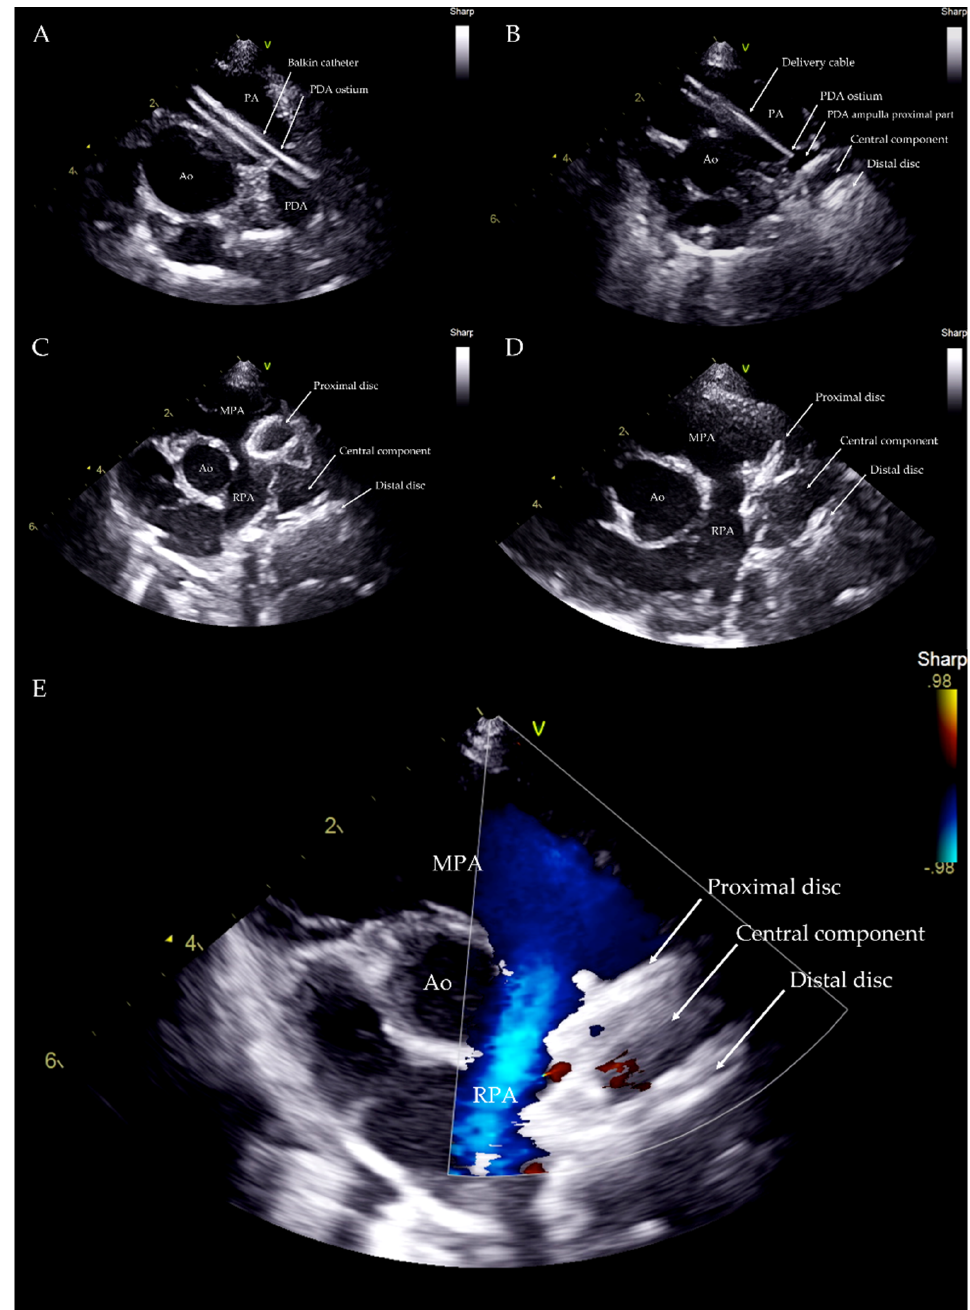
Figure 5. Transthoracic echocardiography from left parasternal cranial view during the procedure. Balkin catheter through the PDA ( A ). Distal disc and central component within the PDA ampulla ( B ). Distal disc and central component within the PDA ampulla and proximal disc within the PA just before the device deployment ( C ). Device released within the PDA structure ( D ). Device within the PDA with no residual flow ( E ). Ao: aorta; PA: pulmonary artery; MPA: main pulmonary artery; RPA: right pulmonary artery; V: probe marker.